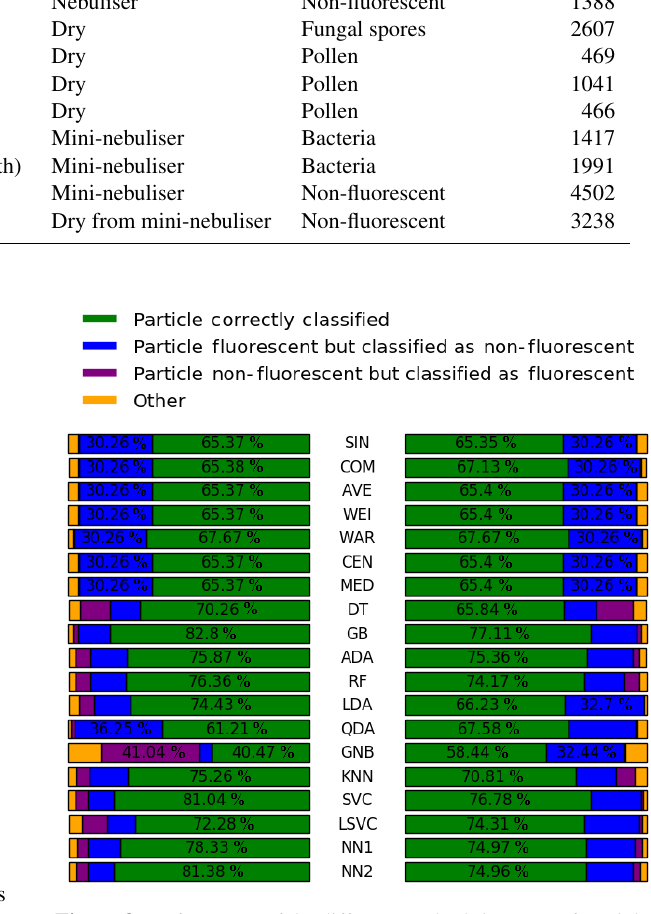
Figure 8. Performance of the different methods in terms of particles correctly classified and a breakdown of the errors for the laboratory- generated aerosols. The results on the left are for the full data set and on the right are the results for the reduced data set. Full names of each of the methods are given in Table